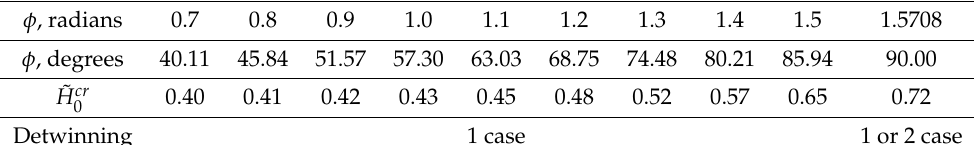
Table 2. The values, at which the detwinning process